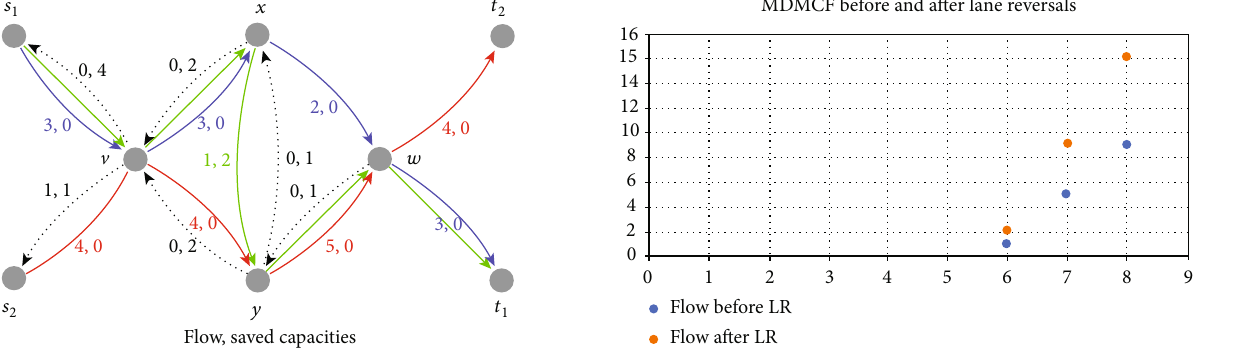
Figure 3: A network with the fl ow and saved capacities on arcs.